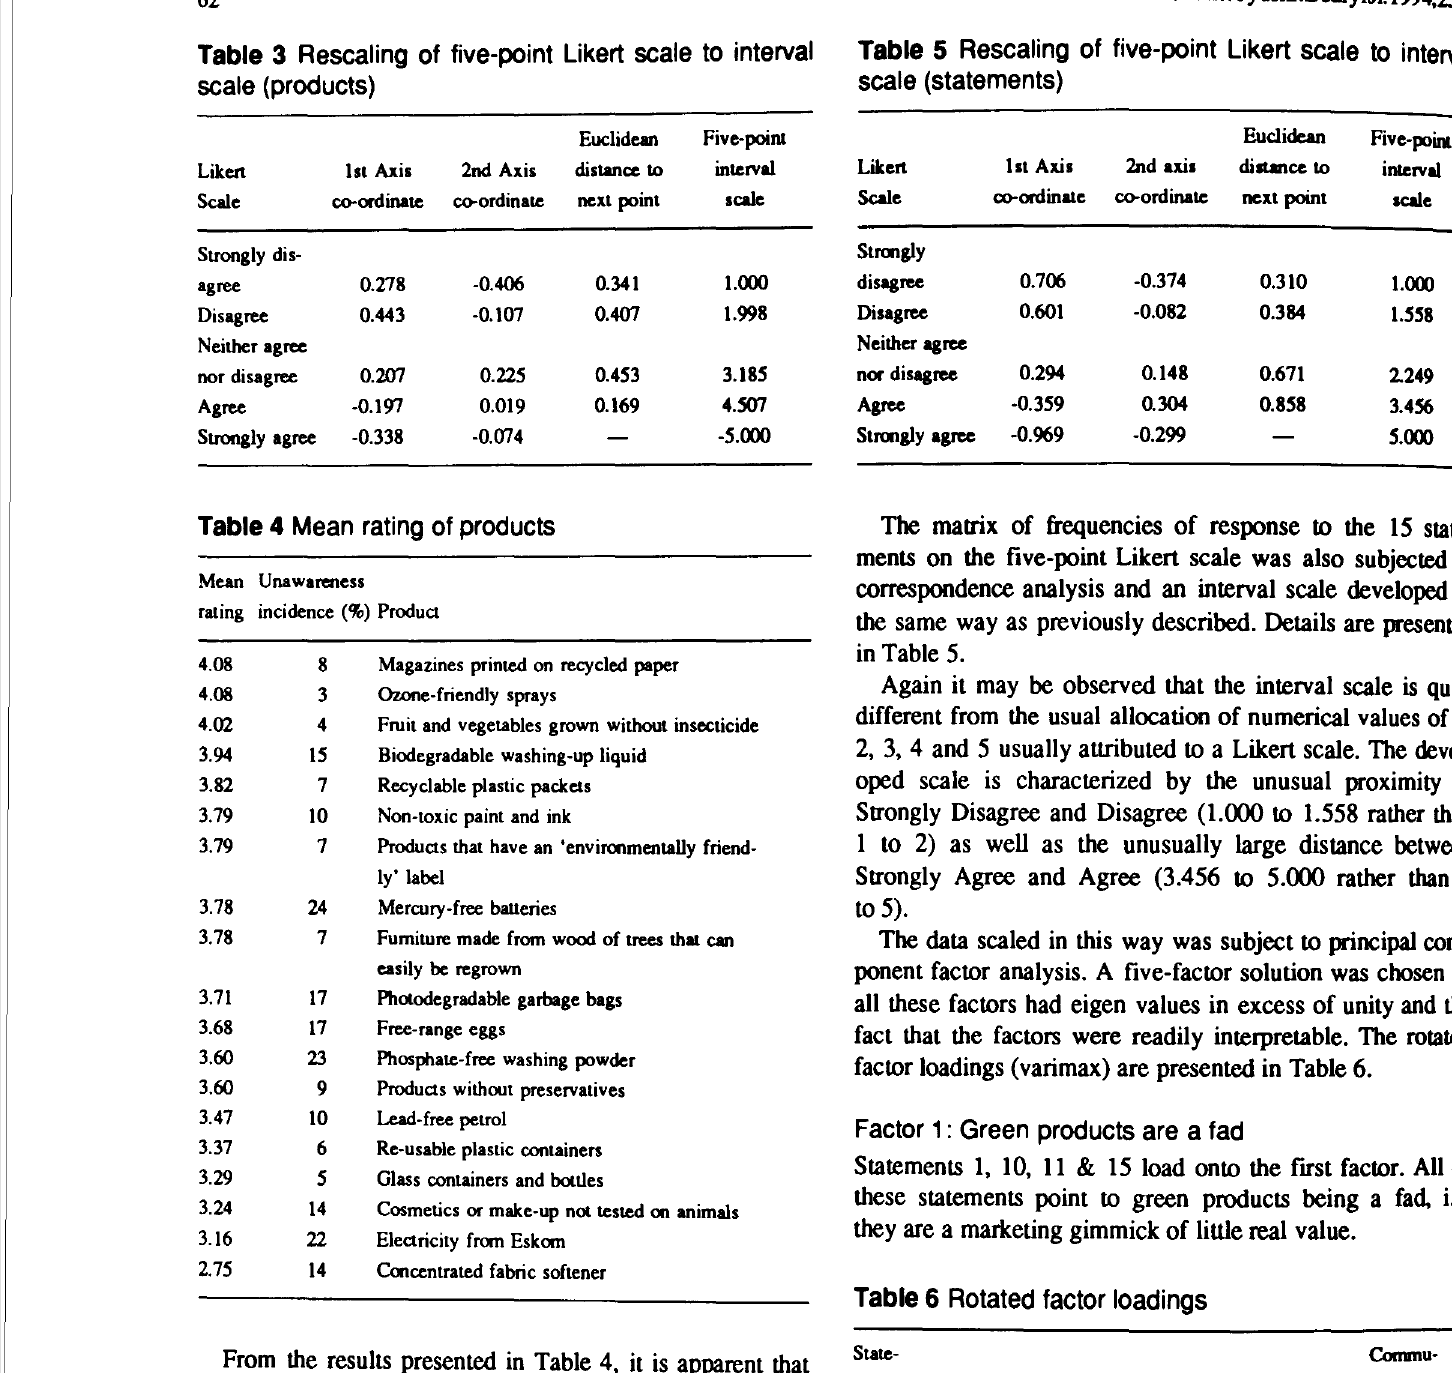
Table 3 Rescaling of five-point Likert scale to interval